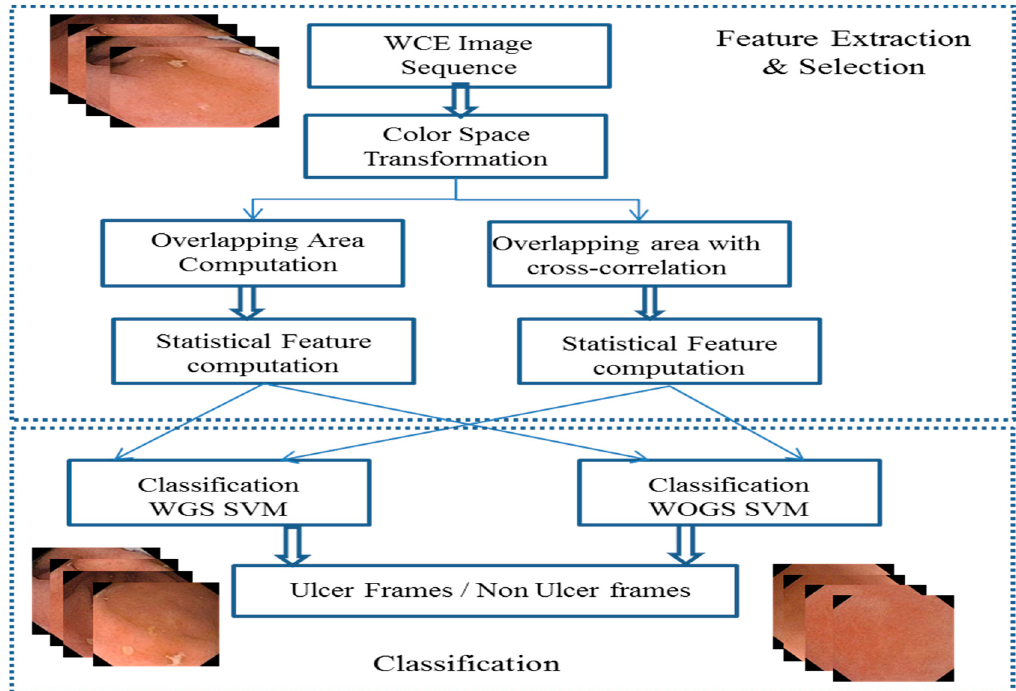
Figure 2. Methodology of proposed feature selection and classification.